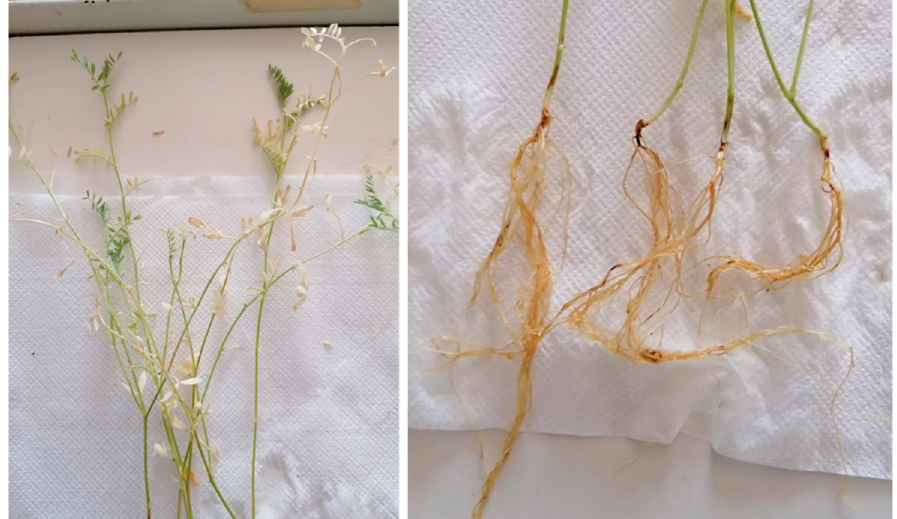
Figure 4 . Symptoms caused by F. oxysporum CREA OF 190.4 on lentil seedlings. In the left panel the detail of foliage yellowing was reported and, on the right, the crown rot symptoms.